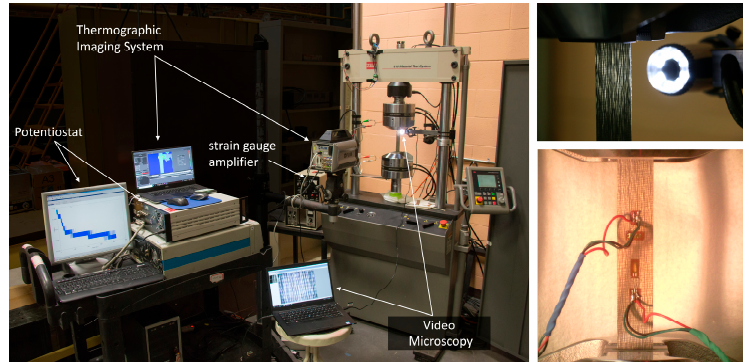
Figure 8. Overview of the test setup for the static tensile tests and cyclic tension–tension fatigue tests, including resistance measurements (potentiometry), thermographic imaging, online video microscopy and strain gauge measurements.